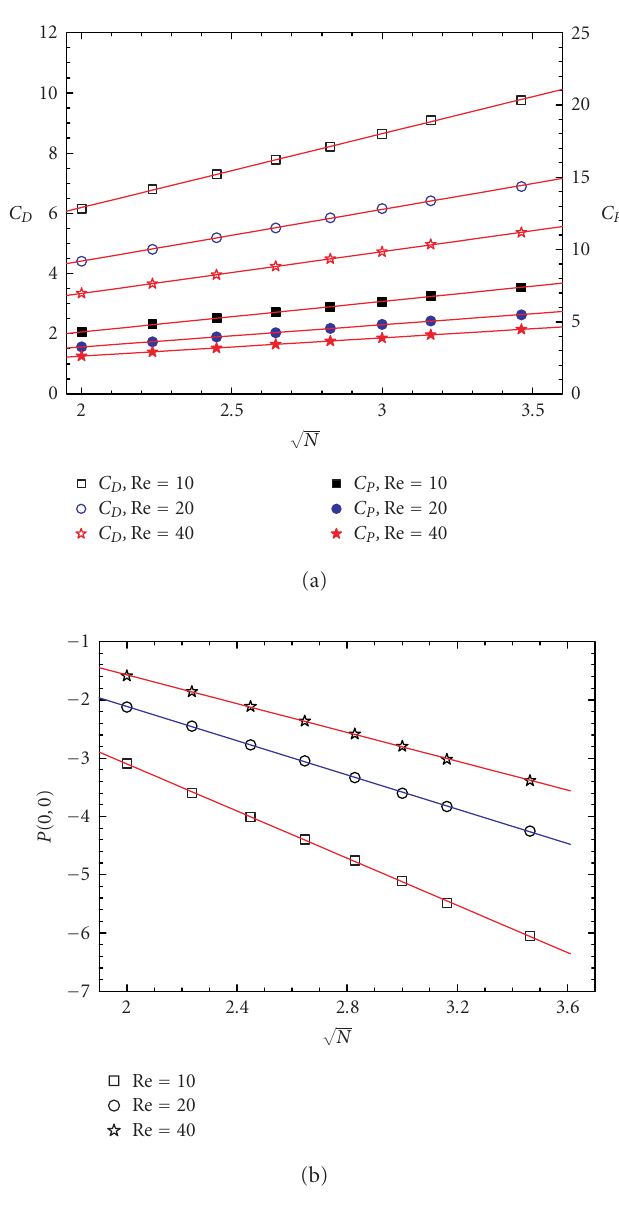
Figure 4.8 . (a) Linear dependence of pressure drag coe ffi cient C P and total drag coe ffi cient C D and √ N (b) the rear pressure P (0,0) on